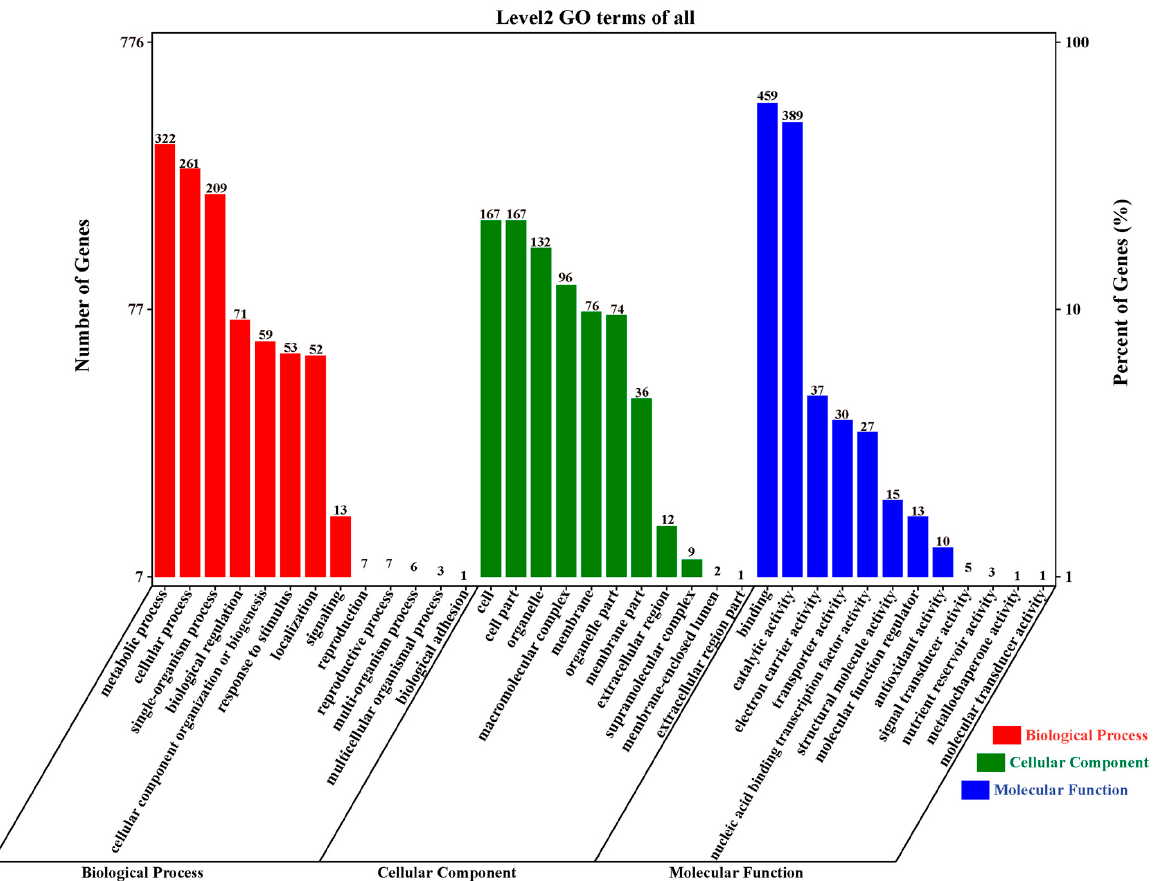
Figure 9. GO function analysis of common differentially expressed genes in G. anomalum under drought stress. Histograms represent the functional distribution; the left y -axis shows the number of genes, and the right y -axis shows a percentage of the number of genes.